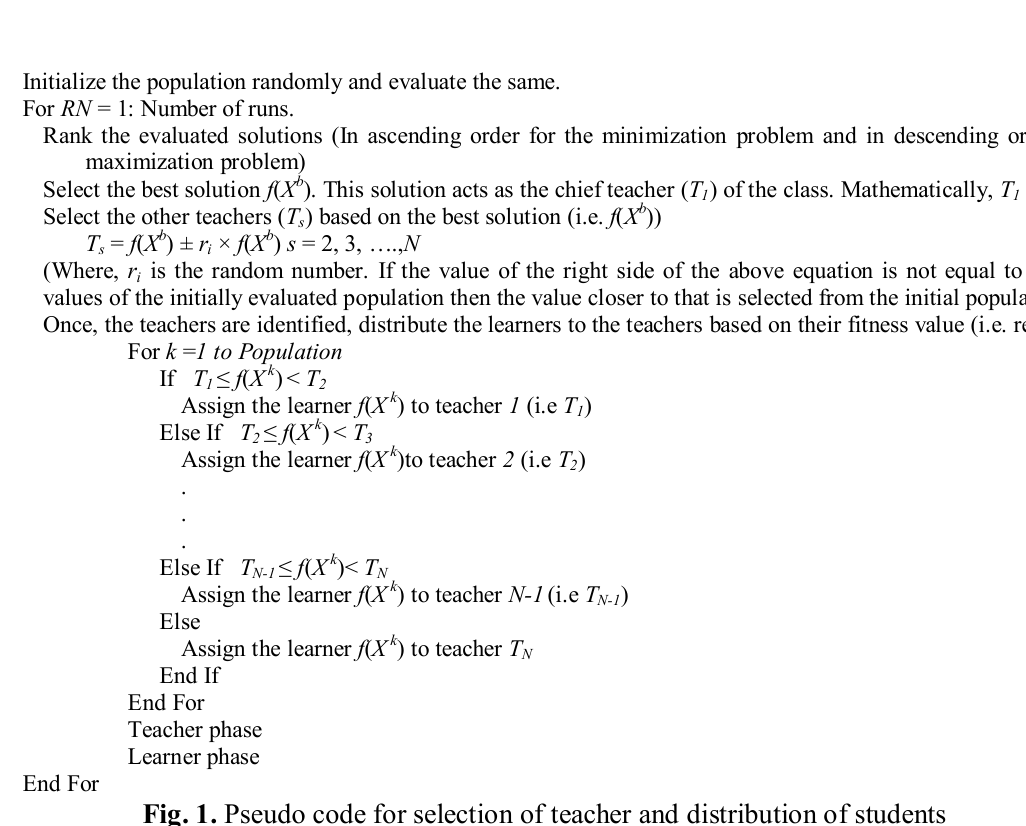
Fig. 1. Pseudo code for selection of teacher and distribution of